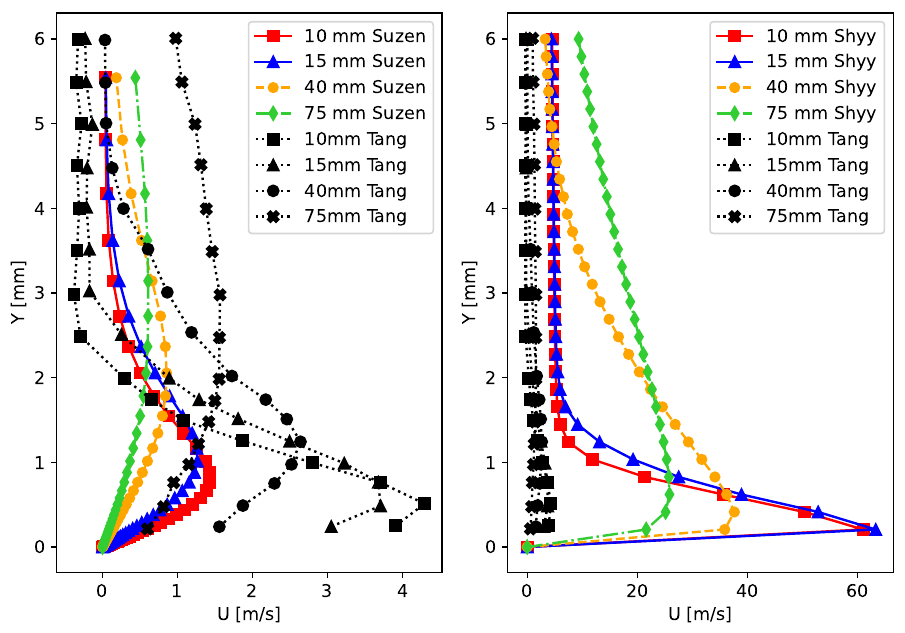
Figure 11. Velocity profiles for the unmodified models (case 2 setup) at 18 kV and 2 kHz.